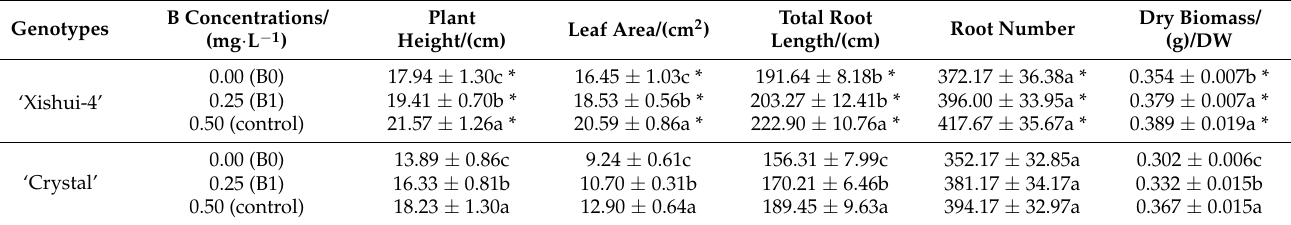
Table 2. Effects of B-deficiency on the growth of two grape seedlings.